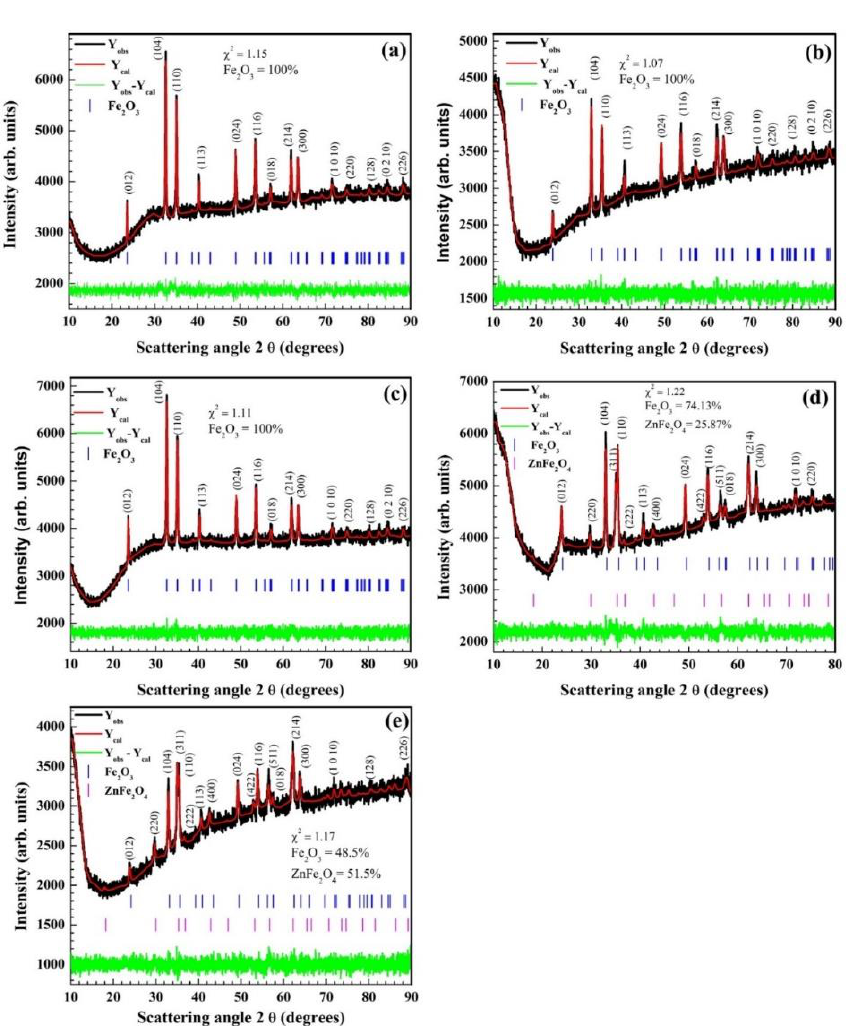
Figure 2. ( a – e ) XRD patterns of pure Fe 2 O 3 and doped with 1%, 3%, 5% and 7% Zn, respectively.